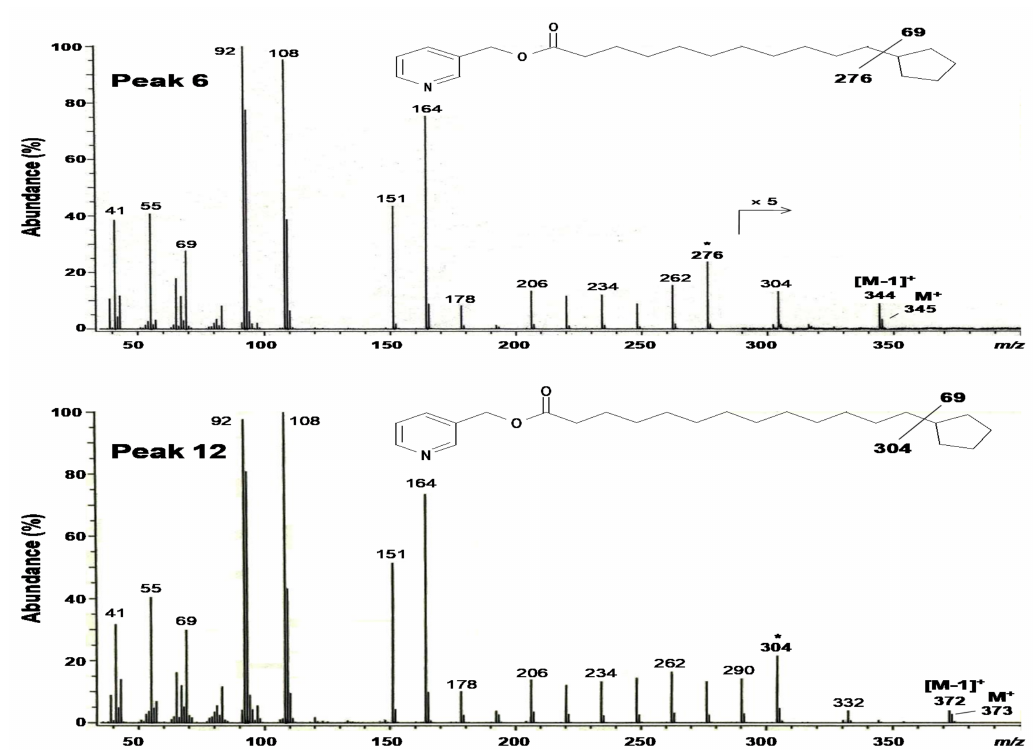
Figure 2. GC-MS profiles of the picolinyl ester derivatives of the saturated fraction of total fatty acids from Solieria pacifica . TIC, total ion chromatogram. Peak 3 = 16:0, Peak 5 = cis -11,12-methylene-hexadecanoic acid, Peak 6 = 11-